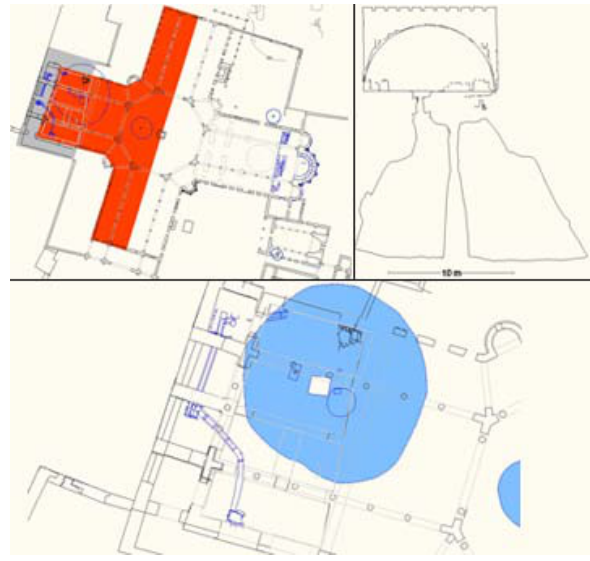
Figure 9. The canalization system under the west basilica